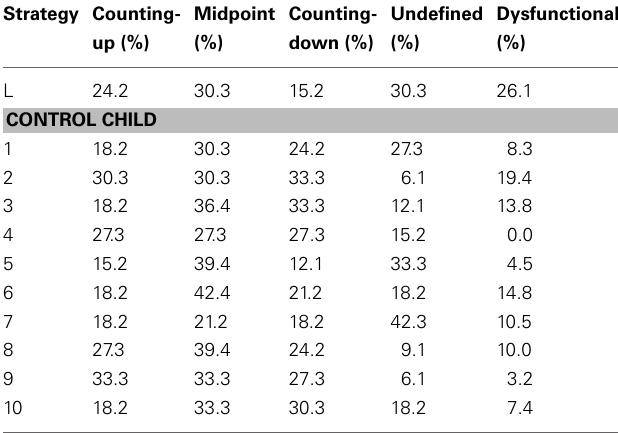
Table A6 | Overview of the individual percentages of the estimation strategies in the symbolic 0–100 number line task of the child with dyscalculia and the control children.